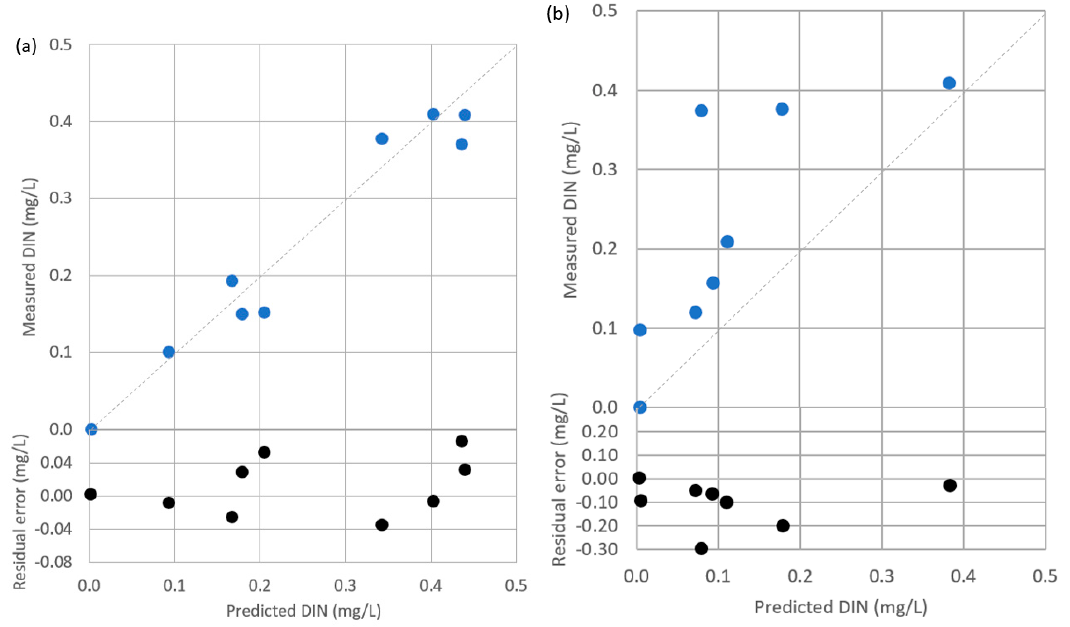
Figure 6. Scatter plots of observed and predicted DIN concentrations for ( a ) calibration and ( b ) validation (1:1 line provided).